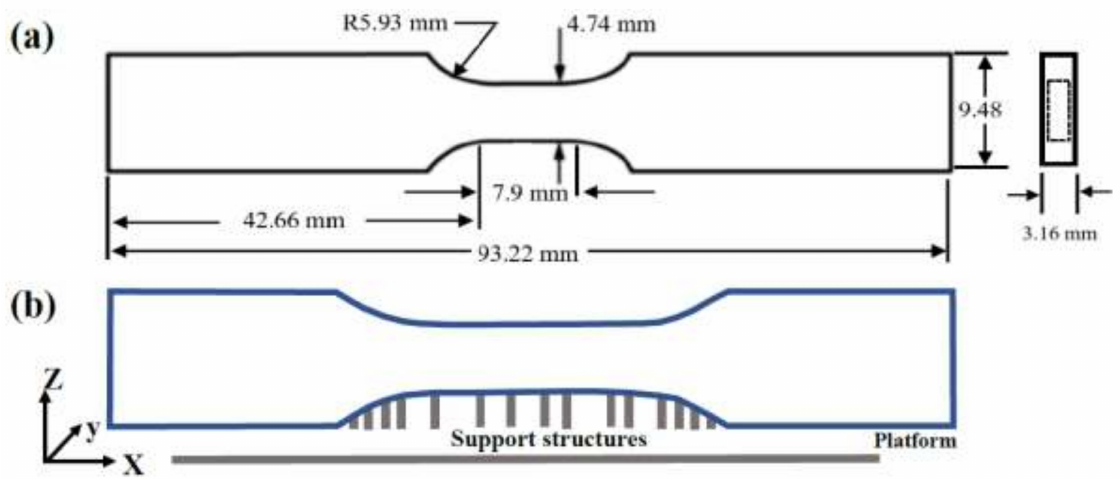
Figure 1. Specimens design and preparation. ( a ) Schematic of flat sheet fatigue specimen with rectangular cross-section; ( b ) orientation of the specimens during DMLS manufacturing